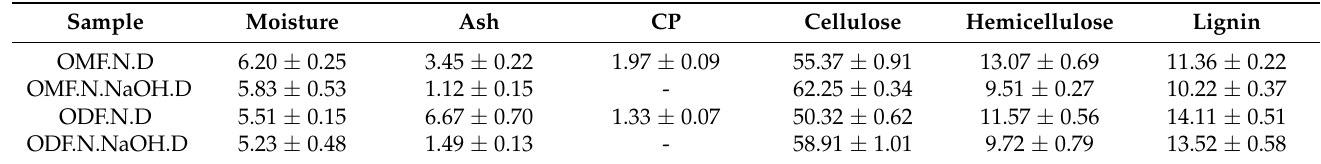
Table 4. Composition of O. maxima and O. dillenii fibre (% wt in dry